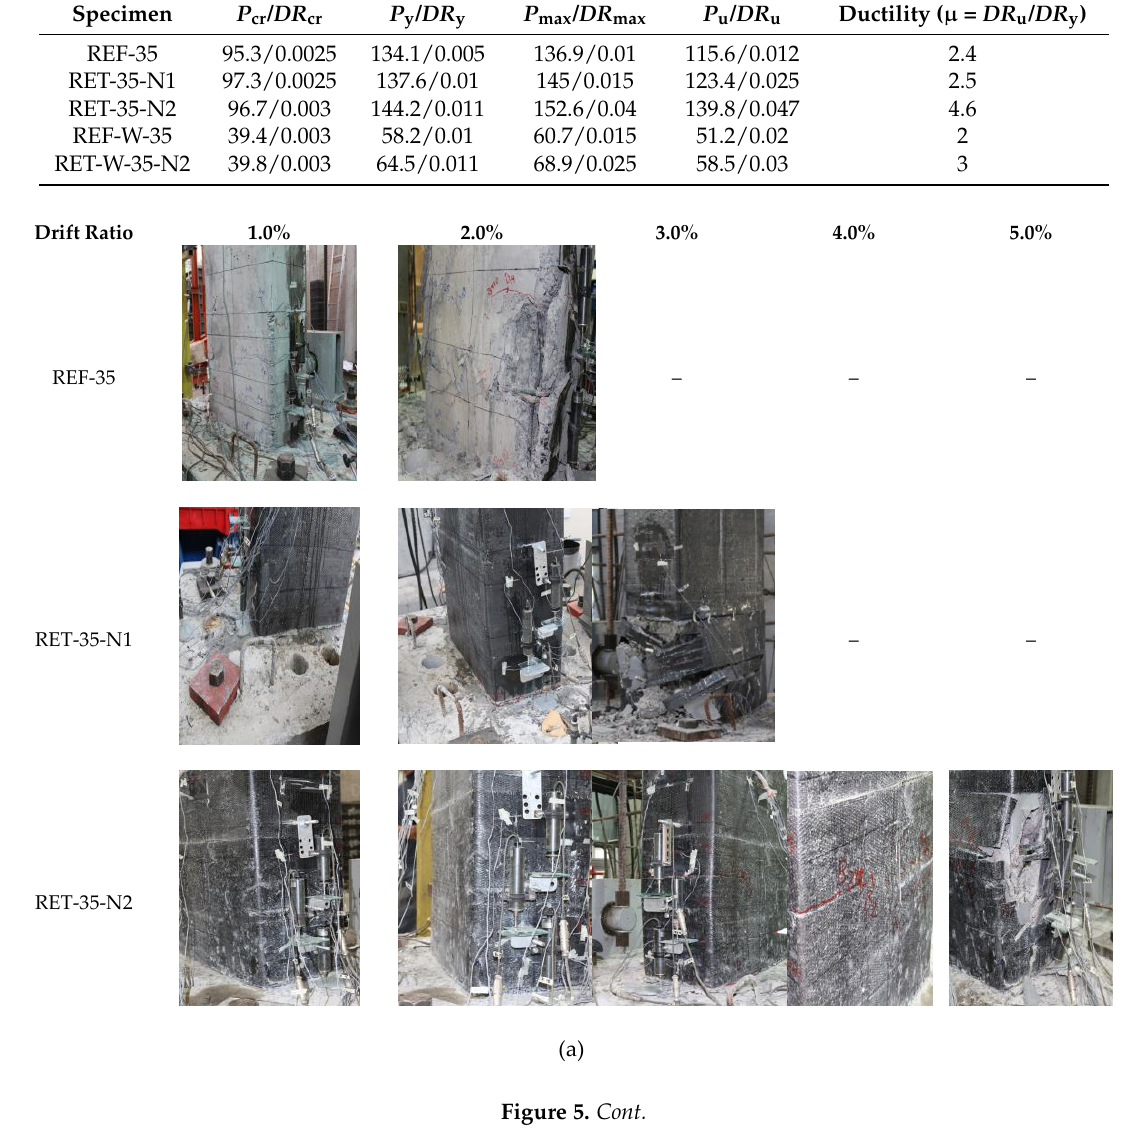
Table 4. Summary of the test results (loads are in kN).